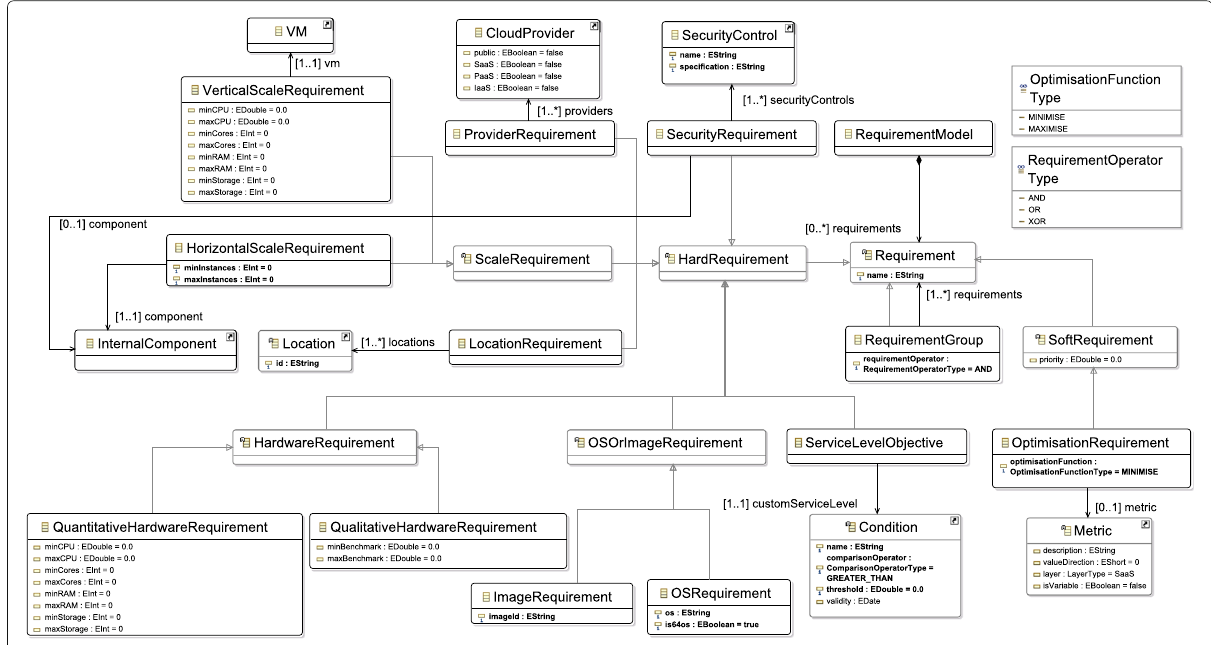
Fig. 5 The requirement